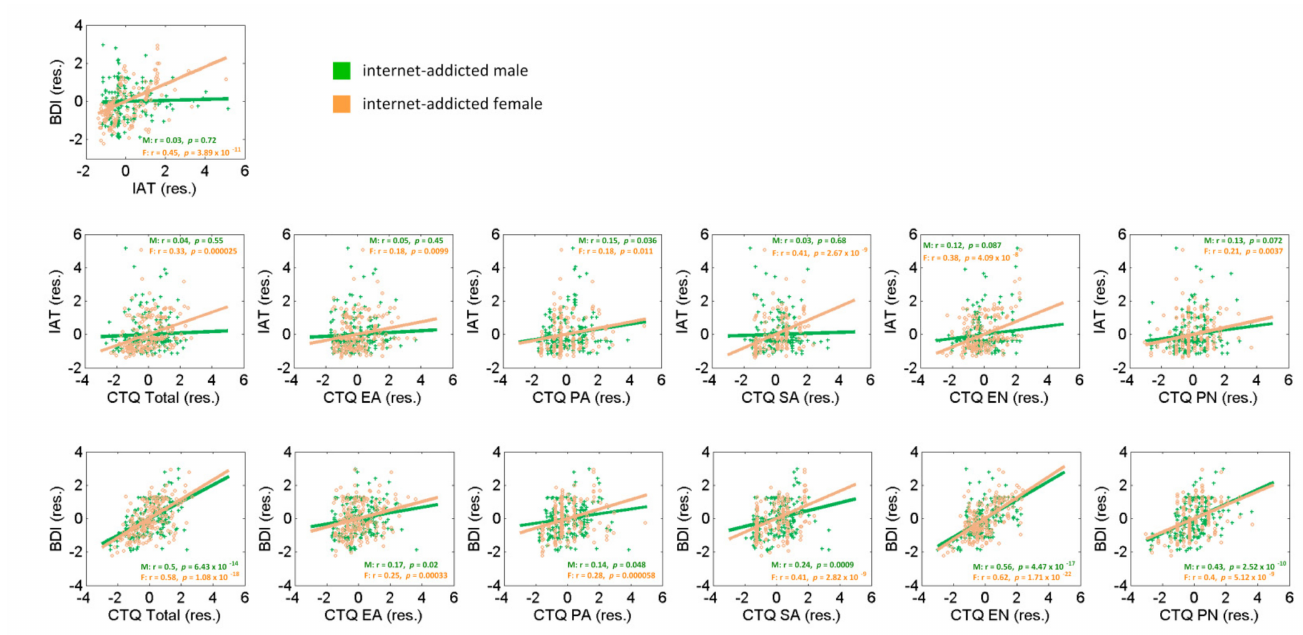
Figure 3. Linear regression of the BDI, IAT and CTQ totals and subscores shown separately for the internet-addicted males and females with age as a covariate. Each data point represents the residual after accounting for age. Green (crosses) and orange (circles) show the data points and regression lines for males and females,